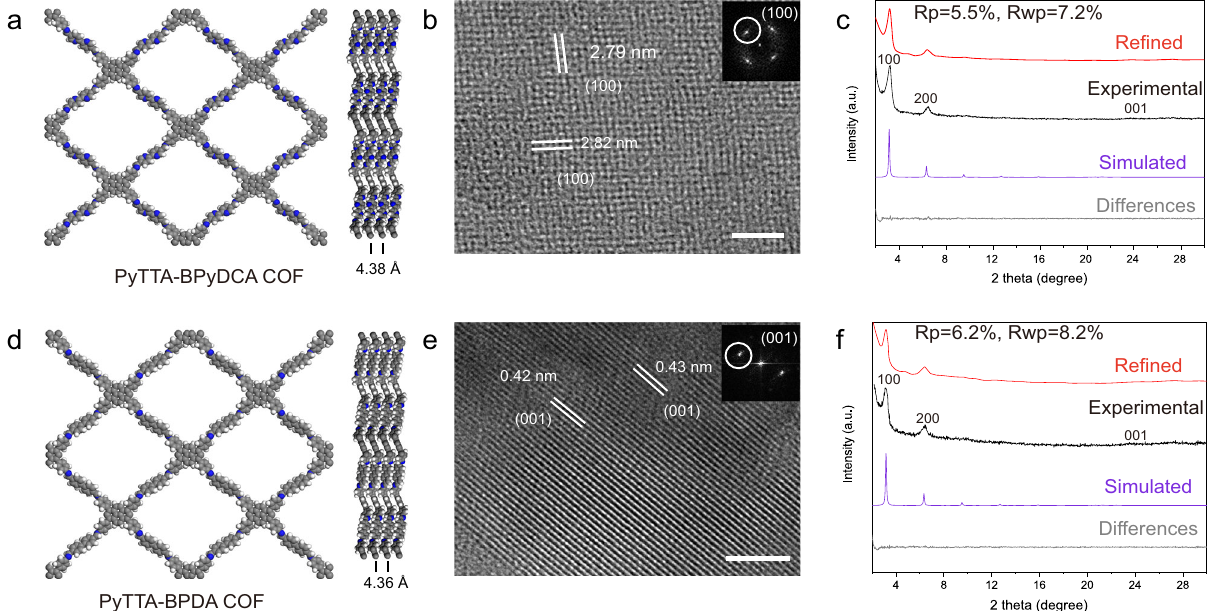
Fig. 4 GIWAXS and TEM characterizations of PyTTA-BPyDCA and PyTTA-BPDA COF fi lms. a Simulated molecular structure of PyTTA-BPyDCA COF based on AA-stacking mode. b HRTEM of the PyTTA-BPyDCA COF fi lm. Scale bar 20 nm. c Theoretical and experimental GIWAXS of the PyTTA-BPyDCA fi lm. d Simulated molecular structure of PyTTA-BPDA COF based on AA-stacking mode. e HRTEM of the PyTTA-BPDA COF fi lm. Scale bar 5 nm. f Theoretical and experimental GIWAXS of the PyTTA-BPDA fi lm. The thickness of PyTTA - BPyDCA and PyTTA-BPDA COF fi lms is about 41 nm and 37 nm